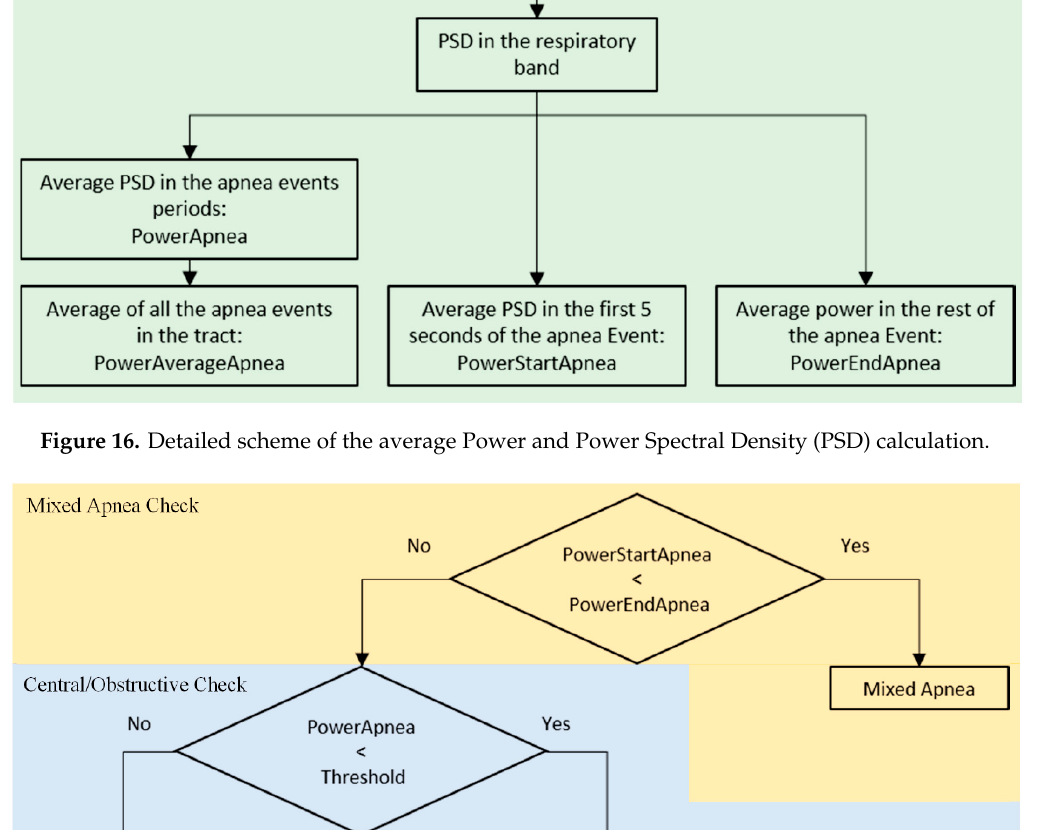
Figure 17. Apnea classification block schemes. Mixed (top) and Obstructive/Central (bottom) checks.